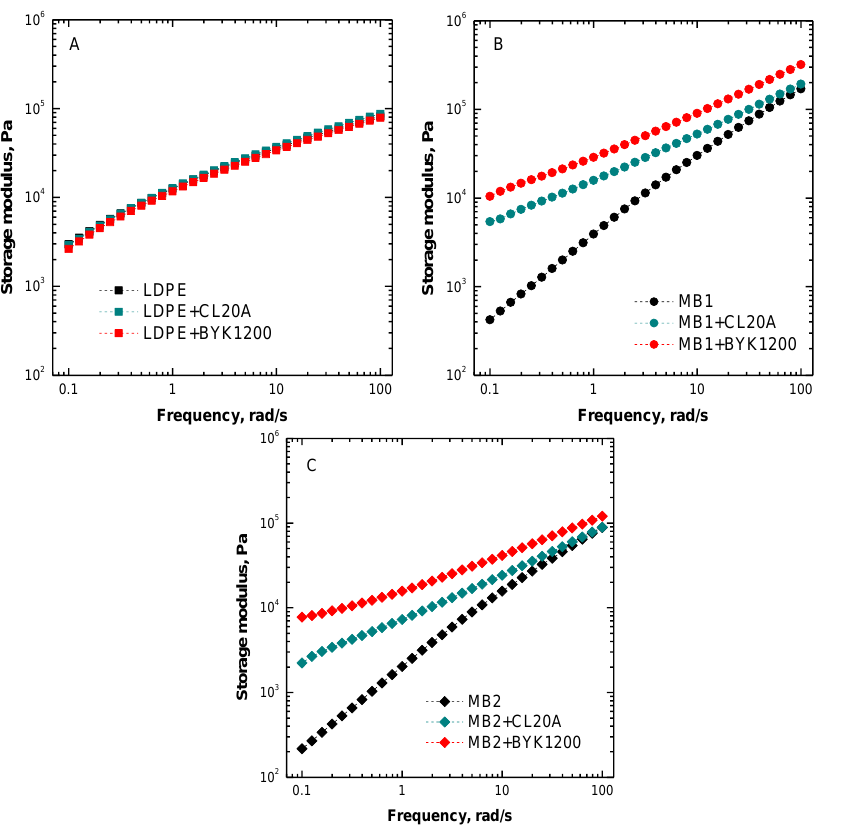
Figure 3. Storage modulus as a function of frequency for ( A ) LDPE-, ( B ) MB1-, and ( C ) MB2-based nanocomposites. The moduli trends for the unfilled matrices are also reported.